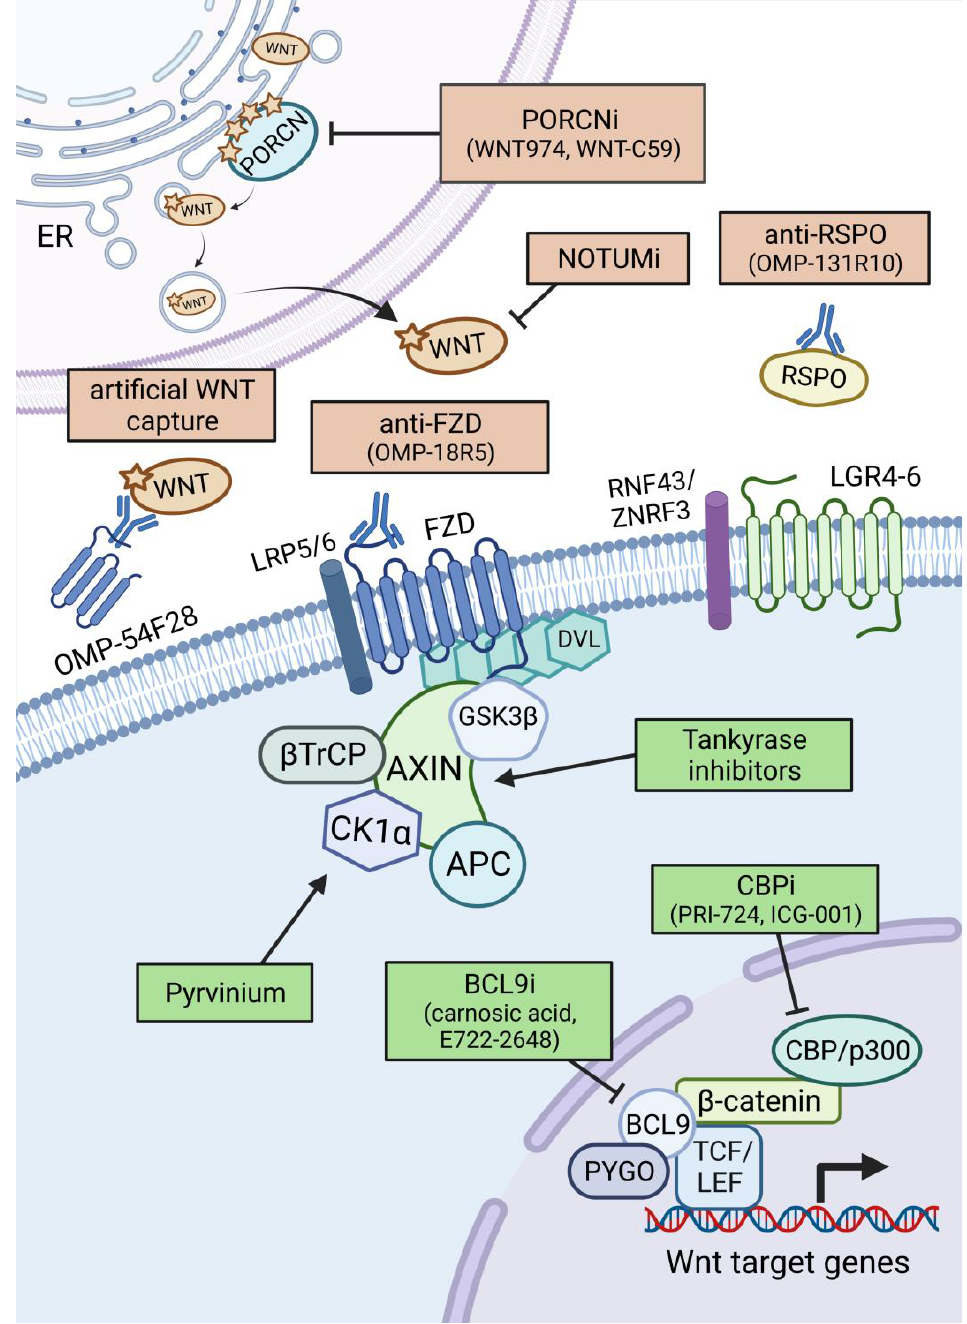
Figure 4. Potential therapies targeting the WNT pathway in cancer. Ligand-dependent (red) inhibitors and antibodies act extracellularly and target WNT ligands and receptors. Ligand-independent (green) inhibitors target β -catenin activity. Ligand-dependent inhibitors are PORCNi (WNT974, WNT-C59) that target the secretion of WNT, the artificial receptor OMP-54F28 that captures secreted WNT with antibodies, anti-FZD (OMP-18R5) antibodies that inhibit FZD receptors, and anti-RSPOs (OMP-131R10) that bind RSPO ligands as well as NOTUMi. Ligand-independent agents are Tankyrase inhibitors that stabilize AXIN and Pyrvinium, which promotes CK1α phosphorylation and results in increased degradation of β -catenin, as well as inhibitors of BCL9 (BCL9i; carnosic acid, E722-2648) and CBP (CBPi; PRI-724, ICG-001) that decrease β -catenin-mediated transcription. Created with BioRender.com.